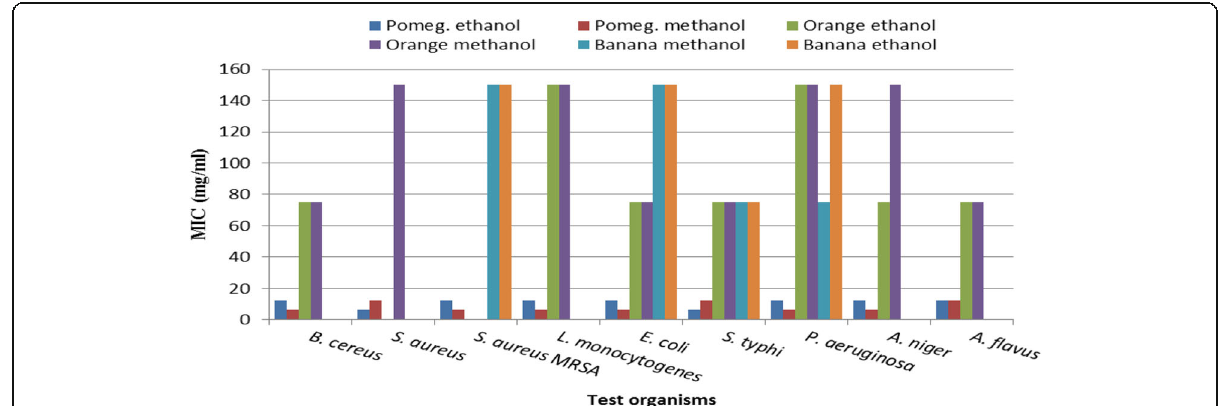
Fig. 2 MIC values of methanolic and ethanolic extracts of pomegranate, orange, and banana peels against tested pathogens